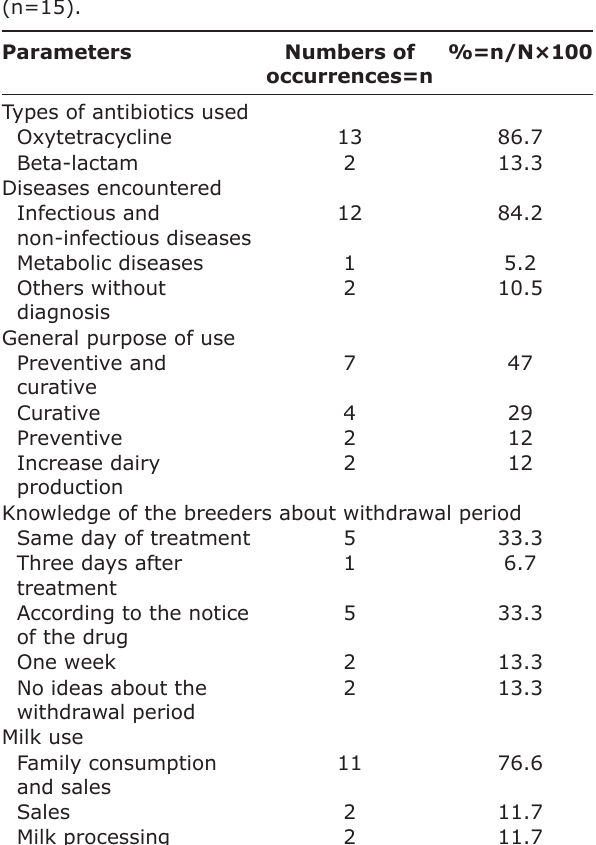
Table-2: Results of the survey as stated by breeders